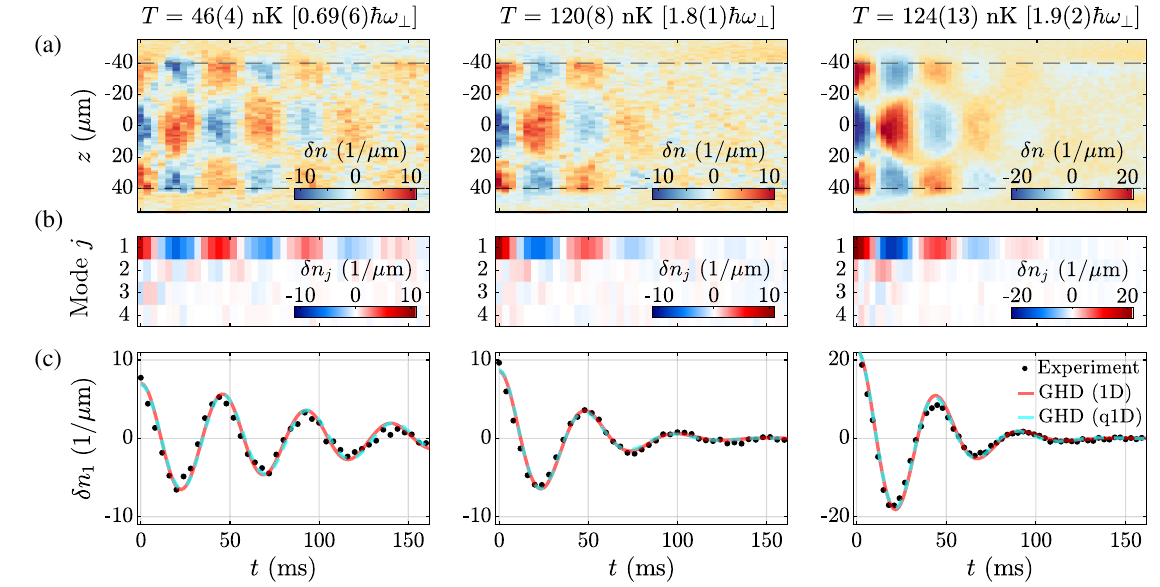
FIG. 2. (a) Measured time evolution of the density perturbation δ n ð z; t Þ ¼ n ð z; t Þ − h n ð z; t Þi for three separate quenches of the lowest t cosine mode. The mean atomic densities are 68, 60, and 82 μ m − 1 , respectively. The dashed lines mark the theoretical position of the hard t Þ obtained via a Fourier decomposition. (c) Evolution of the addressed mode walls. (b) Evolution of the lowest density modes δ n j ð δ n 1 ð t Þ compared with both 1D and quasi-1D GHD